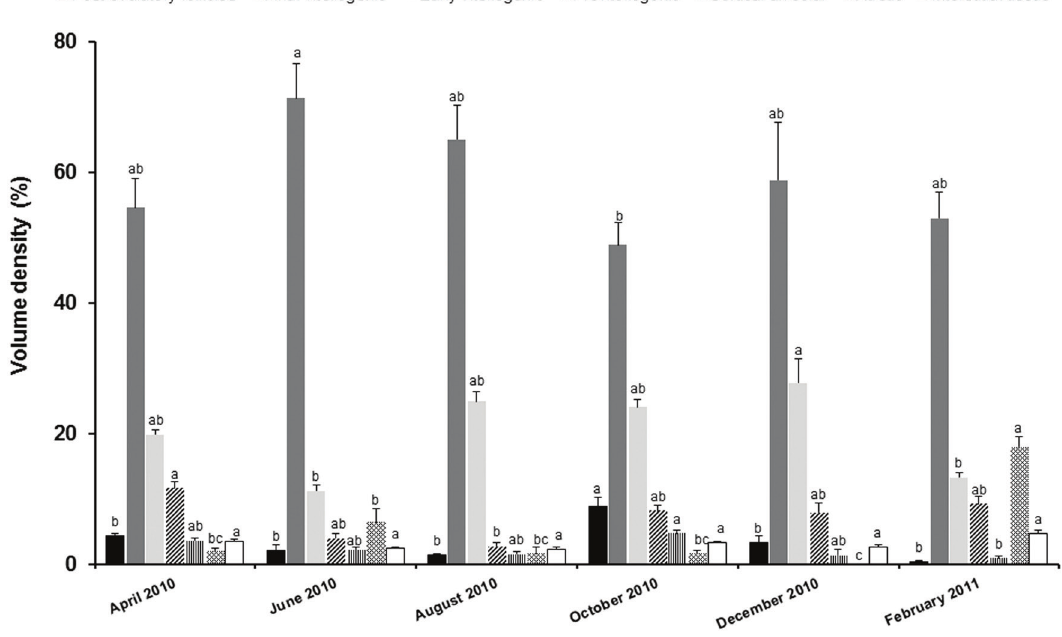
Fig. 3. Mean percentages ( ± S.E.M) of different oocyte types from Metynnis maculatus females during the ovarian maturation cycle. Different letters indicate significant differences among the same type of oocytes among months (ANOVA, Tukey test, P < 0.05).